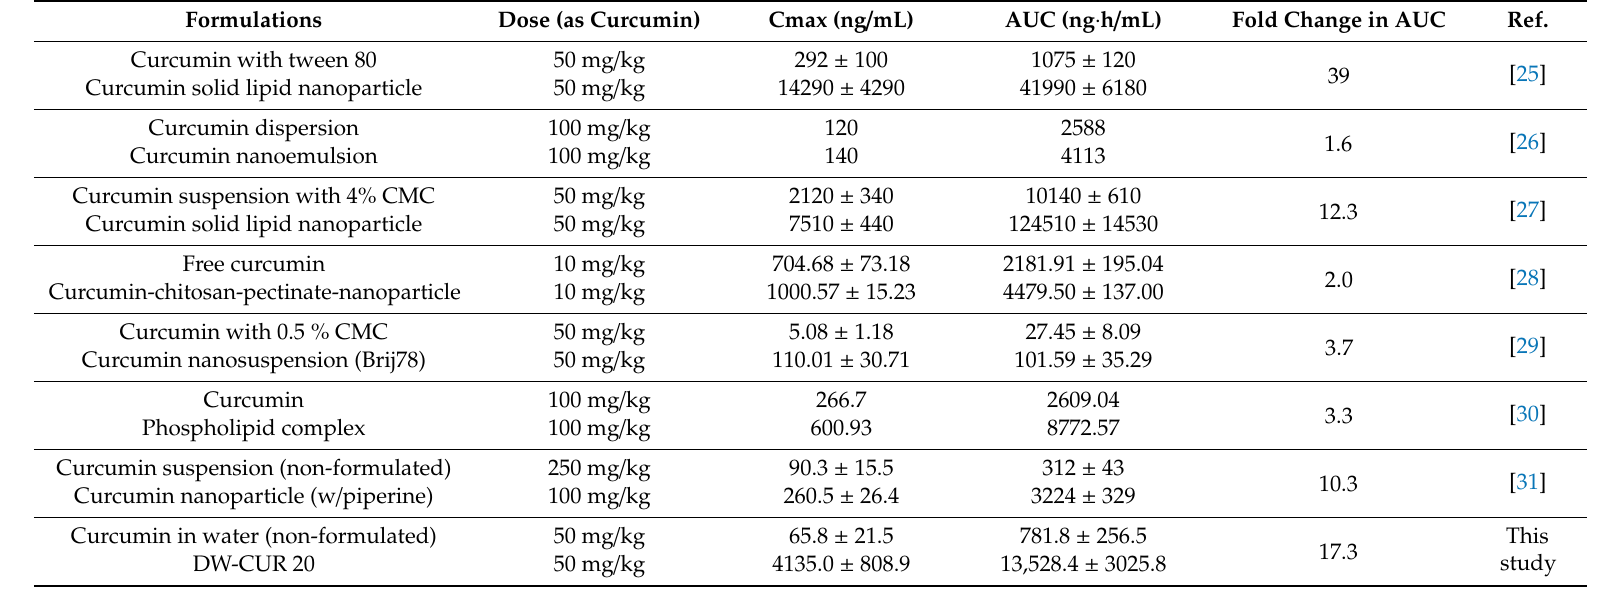
Table 2. The peak plasma concentration (Cmax) and the area under the plasma concentration-time curve (AUC) values of curcumin for di ff erent curcumin formulations.